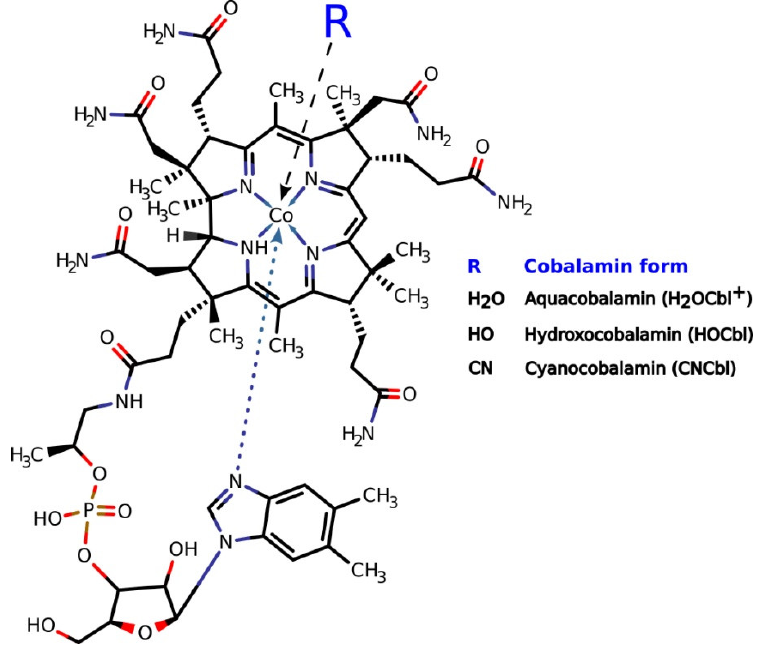
Figure 1. Structure of Vitamin B12.